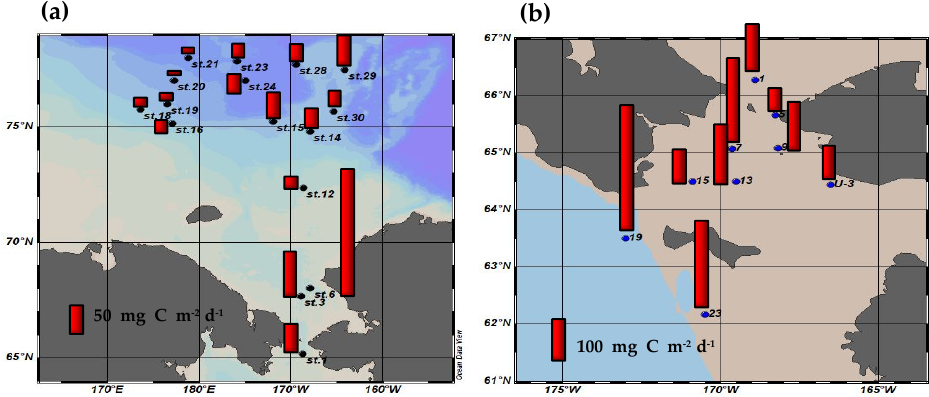
Figure 8. Primary production of small phytoplankton during the ( a ) ARA07B and ( b ) OS040.